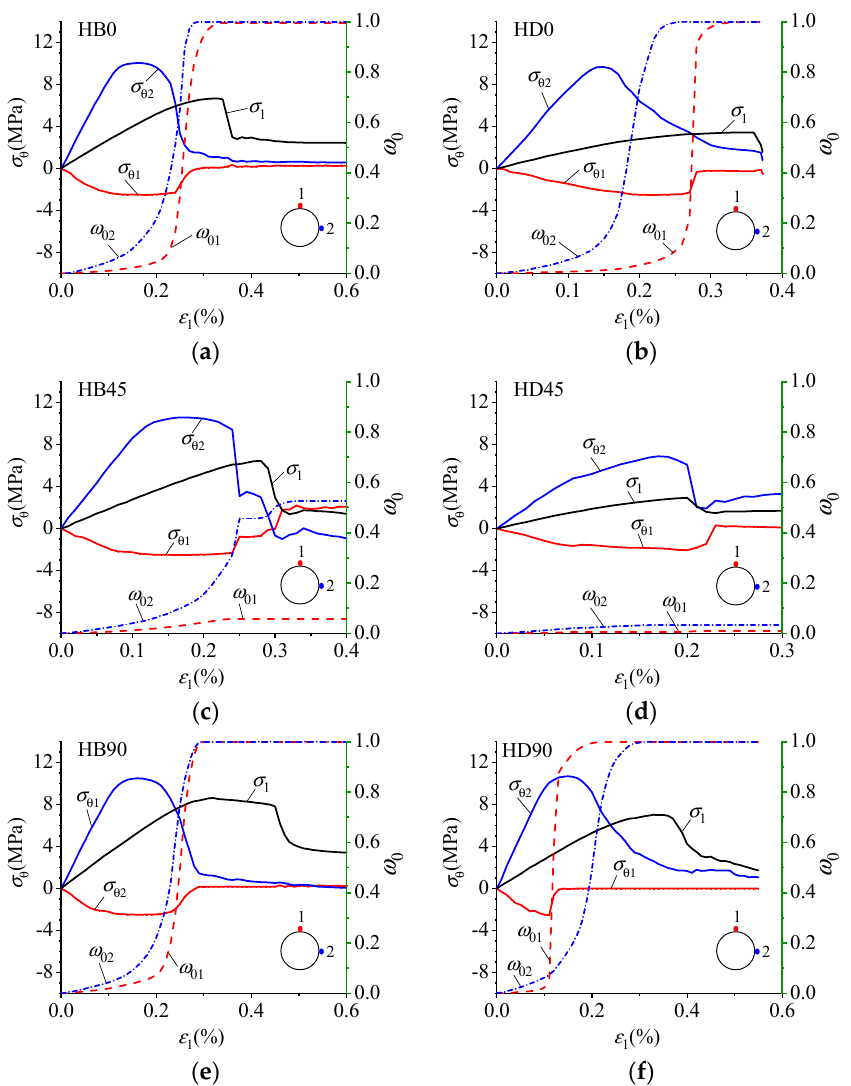
joint continuity factor, curves of σ θ 1 / σ 1 vs. β and σ θ 2 / σ 1 vs. β are anti-V or U, or M shaped with the maxima at β = 30° or 45°, or 60° and the minima at β = 0° or 90°. The hoop stress concentration factor of the two elements σ θ 1 / σ 1 and σ θ 2 / σ 1 increases with the increase in Figure 27. Evolution of σ θ 1 , σ θ 2 , ω 01, and ω 02 in the specimens with k = 0.2 and 0.8 at β = 0°, 45°, and 90°: ( a ) HB0 ( k = 0.2 and β = 0° ); ( b ) HD0 ( k = 0.8 and β = 0° ) ; ( c ) HB45 ( k = 0.2 and β = 45° ) ; ( d ) HD45 ( k = 0.8 and β = 45° ); ( e ) HB90 ( k = 0.2 and β = 90° ); ( f ) HD90 ( k = 0.8 and β = 90° ).